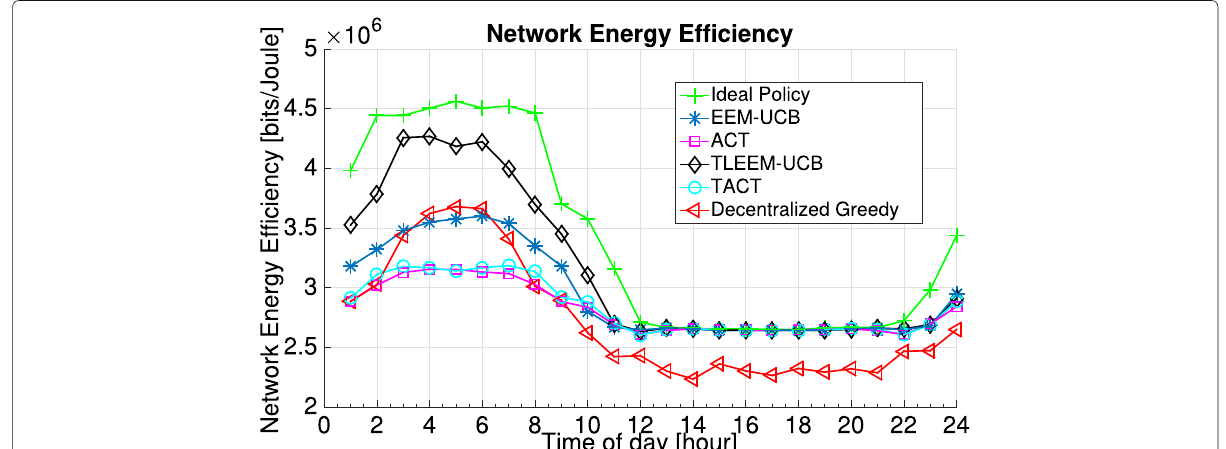
Fig. 7 Network EE obtained with several learning algorithms with respect to time. The figure compares the network EE achieved by several learning policies w.r.t. daytime. The EE is plotted from 1:00 am to 24:00 pm